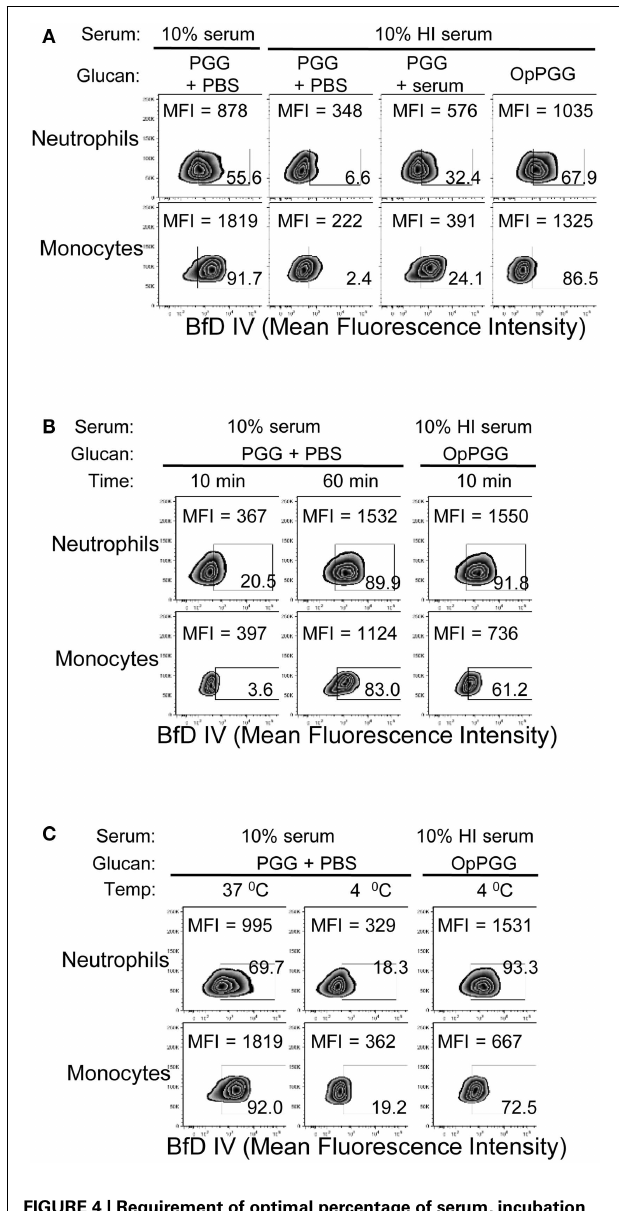
FIGURE 4 | Requirement of optimal percentage of serum, incubation time, and incubation temperature at the ligand level versus the cellular level . (A) PGG β -glucan-treated with PBS (PGG + PBS), PGG β -glucan and serum added separately (PGG + serum), or serum pre-opsonized PGG β -glucan (OpPGG) were added at concentration 100 µ g/mL to neutrophils or to PBMC, incubated for 1h at 37°C in 10% serum or 10% HI serum, and binding was measured by flow cytometry. (B) Binding was measured at 37°C after incubating PGG or OpPGG with the cells for 10min or 1h in RPMI containing 10% serum or 10% HI serum. (C) Binding was measured at 4°C after incubating PGG or OpPGG with cells as described above. Data shown in the zebra plots with MFI and percentage of BfD IV positive population are representative of three independent experiments performed with cells obtained from three different